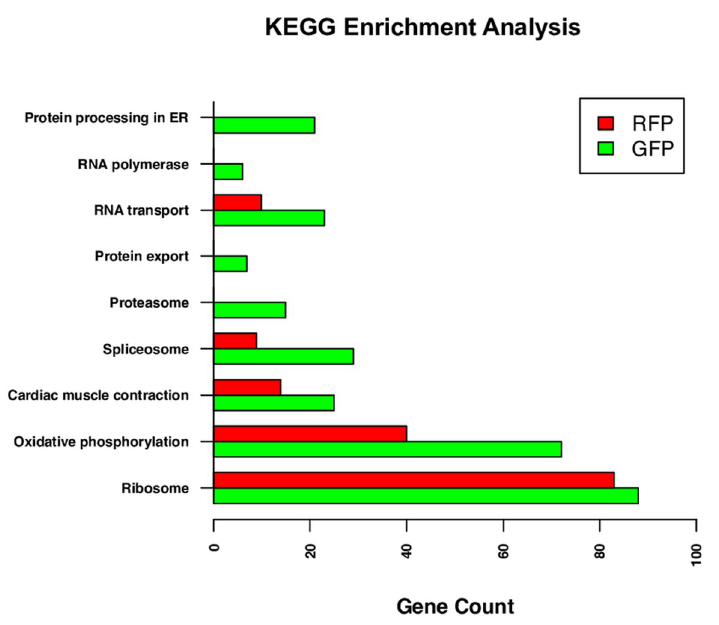
Fig 6. Significantly enriched Kyoto encyclopedia of genes and genomes. The highly expressed gene lists for GFP + and RFP+ thrombocytes were analyzed separately using the DAVID to identify enriched KEGG pathways. Bars represent the number of highly expressed genes in pathways for GFP+ and RFP+ thrombocyte datasets.